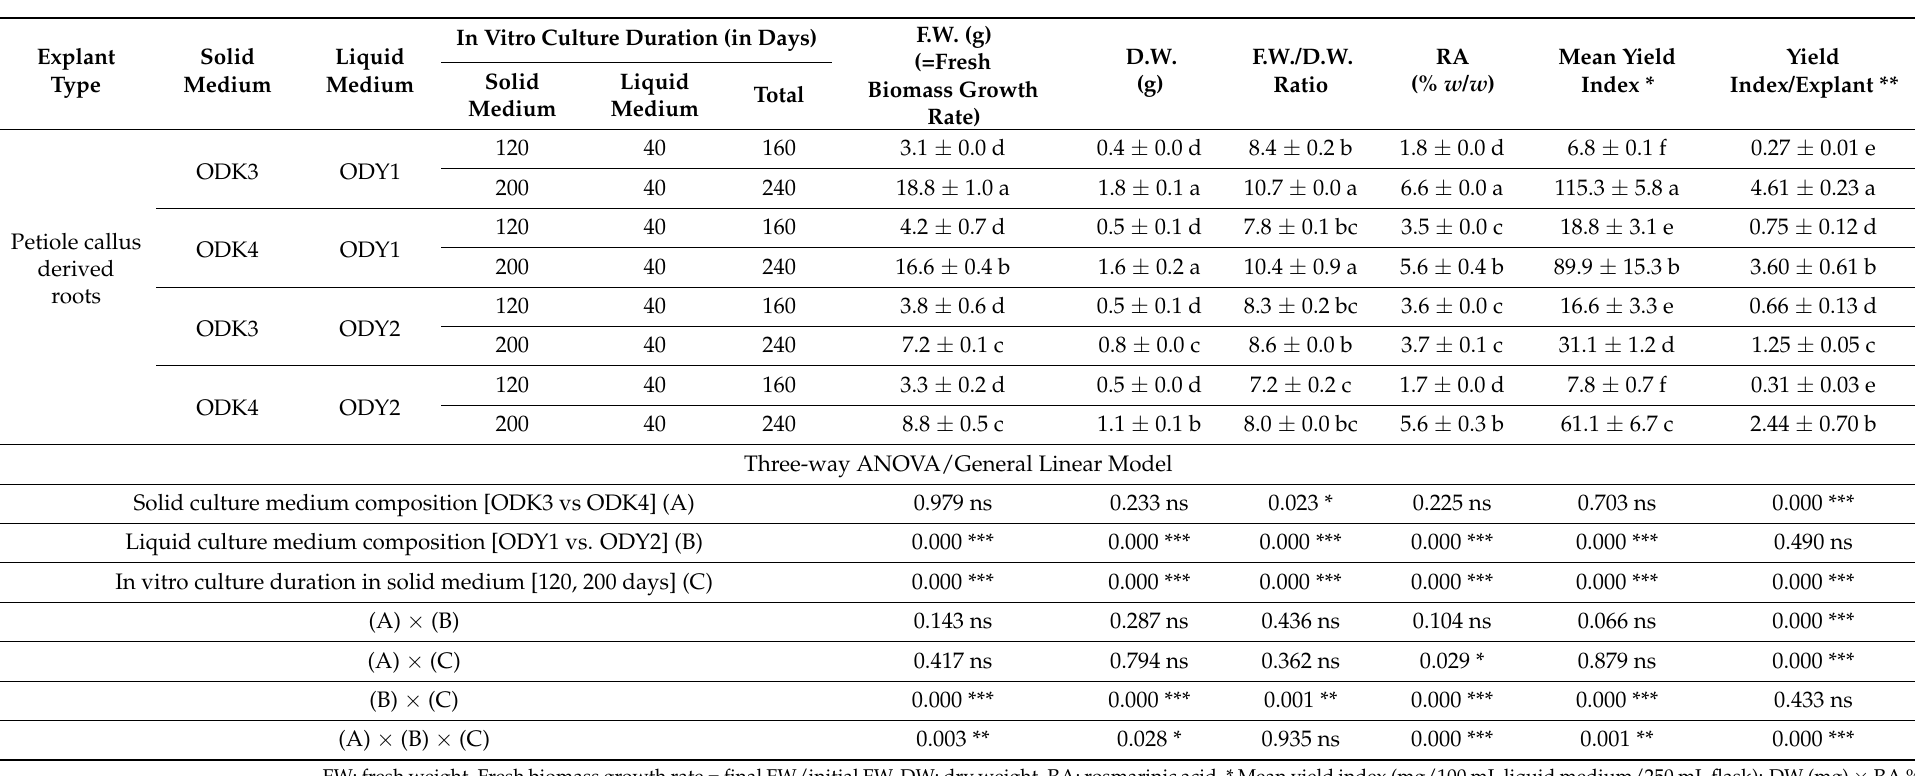
Table 2. Effect of media composition and combinations, and two incubation periods on biomass growth (FW, DW, FW/DW ratio), and RA production expressed